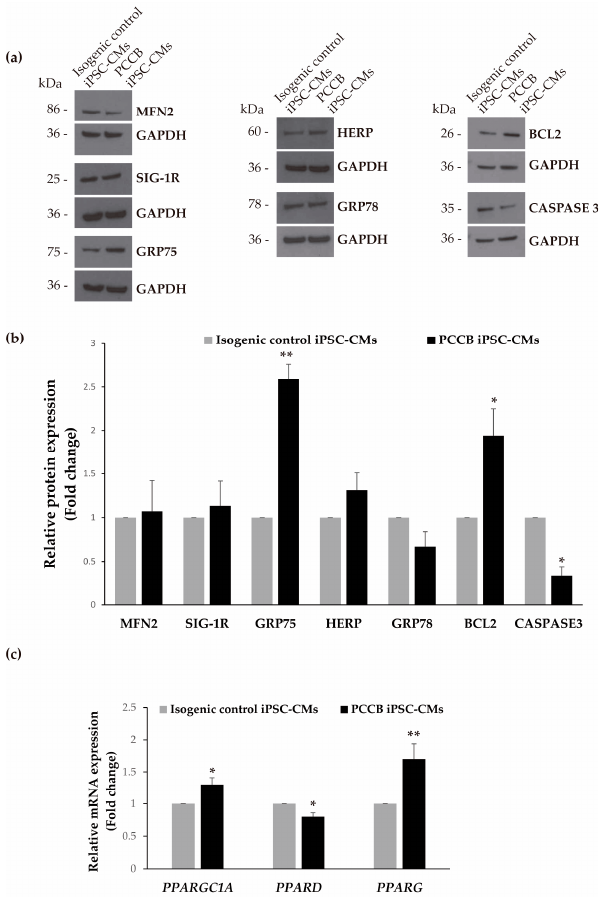
Figure 5. Expression analysis of proteins involved in MAMs, ER stress, apoptosis, and mitochondrial biogenesis in the iPSC-CMs. ( a ) Representative blots of the analysis of MFN2, SIG-1R, GRP75, HERP, GRP78, BCL2, and CASPASE 3 protein levels. GADPH was used as the loading control. ( b ) The corresponding quantification by laser densitometry is shown as the mean ± standard deviation of at least three experiments. Statistical significance was determined by Student’s t -test. ( c ) Rela- tive mRNA expression of PPARGC1A , PPARD, and PPARG genes by qRT-PCR. Data represent the mean ± standard deviation of at least three experiments. Statistical significance was determined by Student’s t -test. * p < 0.05; ** p <